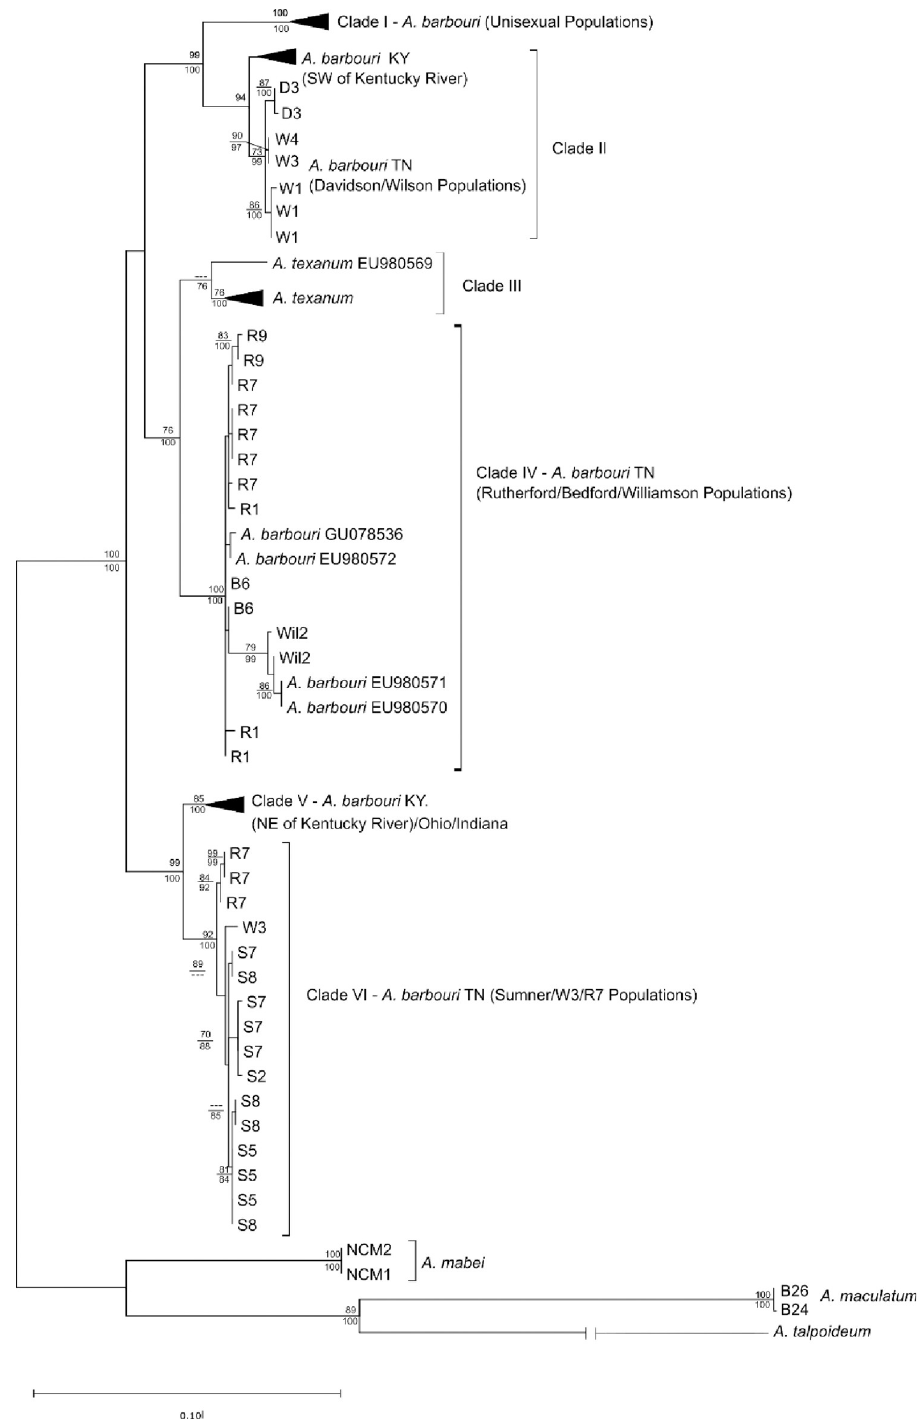
Fig 3. Phylogenetic tree of A . barbouri mitochondrial haplotypes. Maximum likelihood phylogenetic reconstructions of unique mitochondrial D-loop haplotypes from Ambystoma barbouri and A . texanum under a GTRCAT model of evolution as performed by RaxML. Bootstrap support values above branches are shown for nodes with 70% support or greater. Values below nodes indicate posterior probabilities from Bayesian reconstructions under a T92+G model of sequence evolution as performed by MrBayes. Asterisks denote accession numbers for sequences downloaded from Genbank.